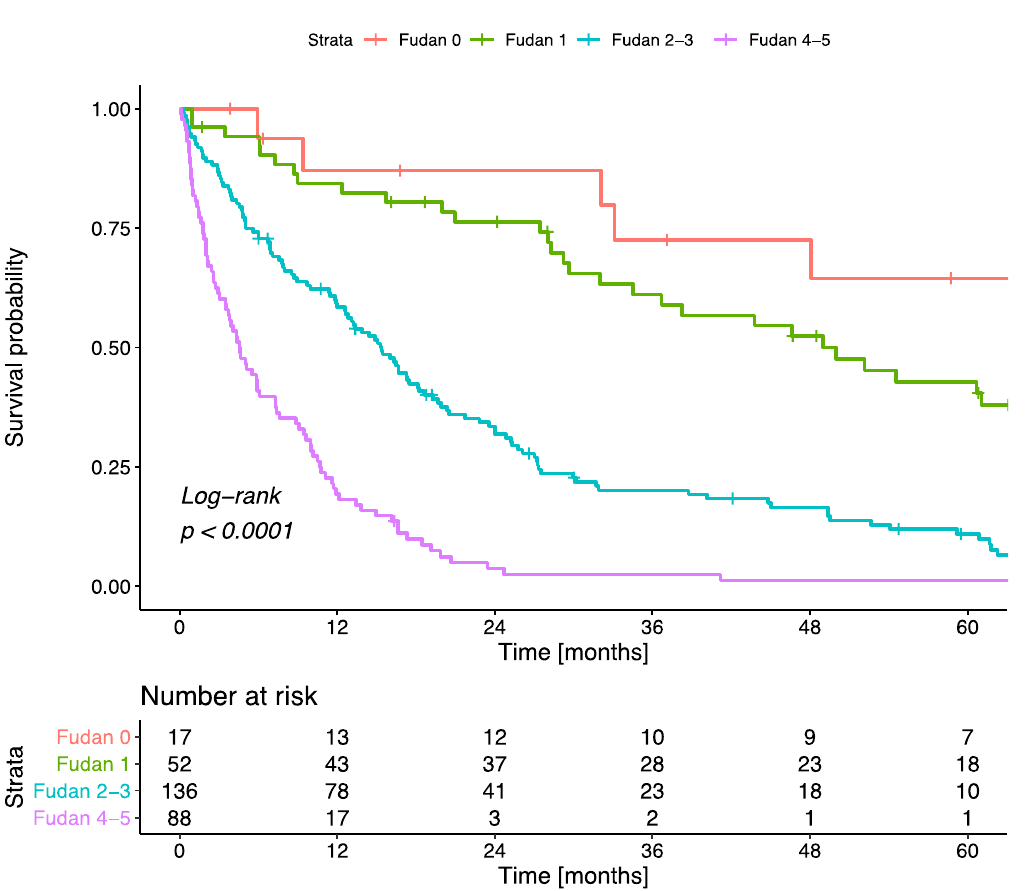
curves for the training (blue) and validation (red) sets.